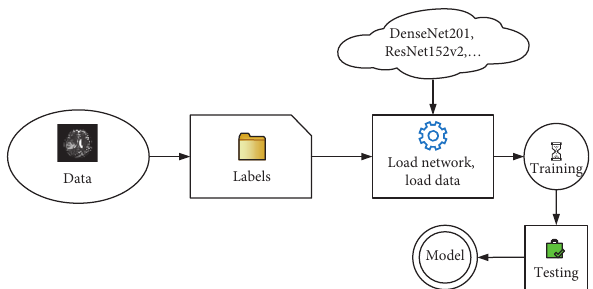
Figure 5: The process of creating a model of the algorithm.